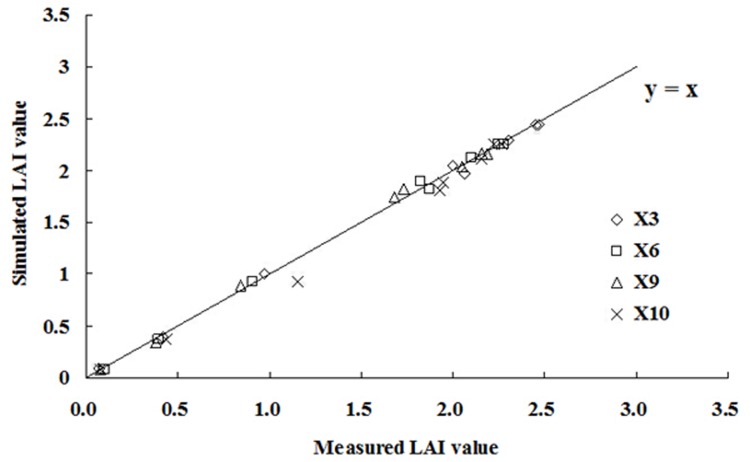
Predicted LAIs calculated with Eq 22.